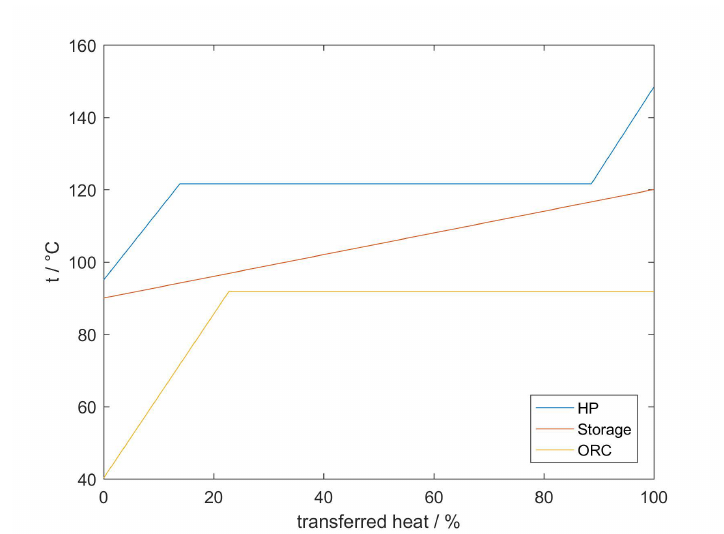
Figure 5. t-Q-diagram for the heat storage heat exchanger for HP and